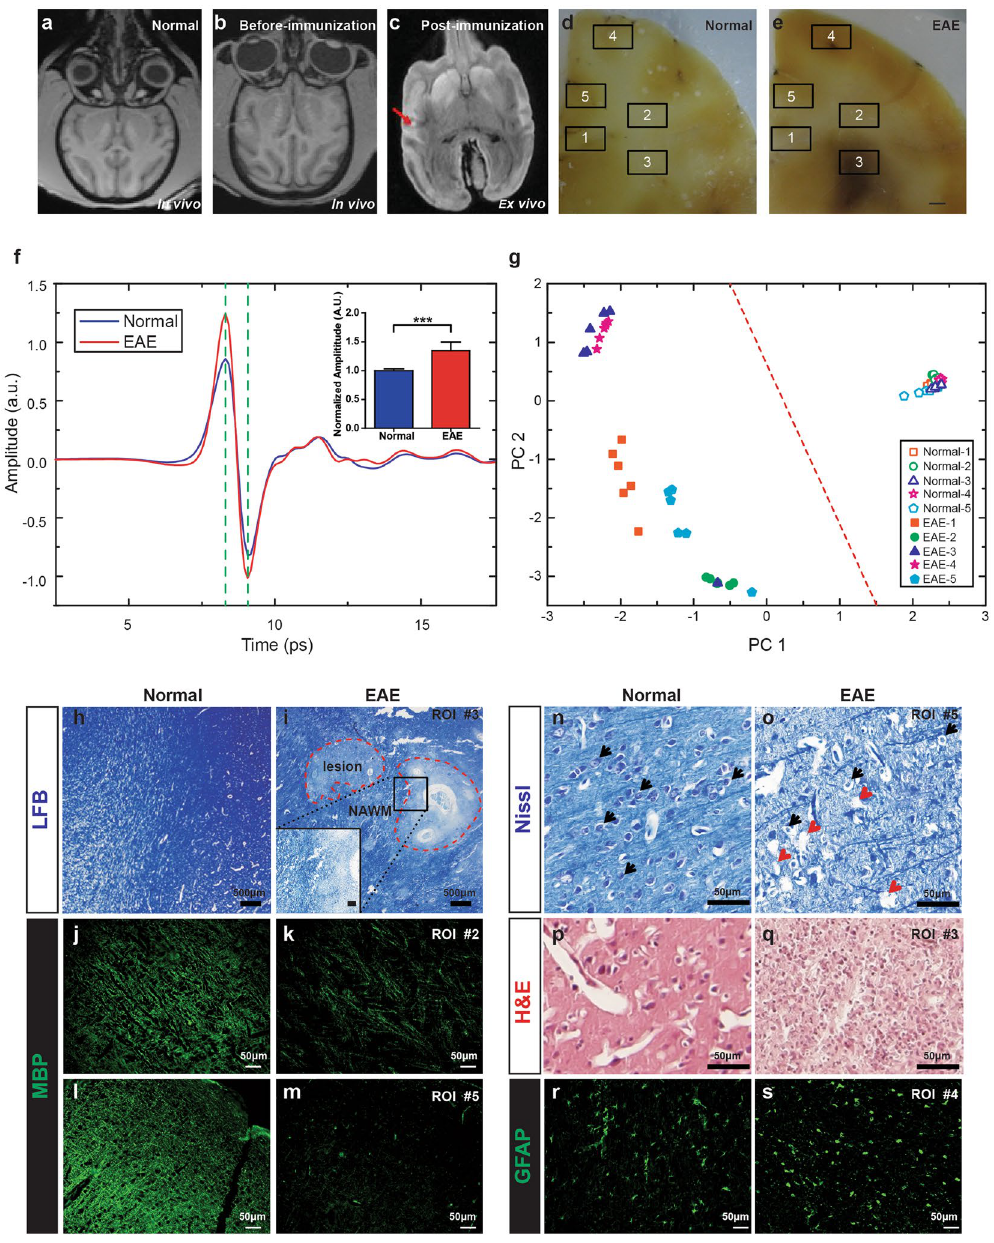
Figure 4. Distinguishing brain from EAE monkey by THz-TDS with PCA. ( a – c ) Examples show MRI of normal monkey, EAE monkey before immunization, and EAE monkey post-immunization. ( d and e ) White- field images of paraffin-embedded brain coronal sections from normal and EAE monkeys. ( f ) THz time- domain waveforms reflected from the regions of interest (ROIs) in normal monkey (blue) and EAE monkey brain samples (red). ( g ) Score plot of the first two principle components for the EAE and normal monkey brain tissues. The solid and hollow figures represent the calculation results for the EAE and the normal brains, respectively. ( h , i ) LFB staining shows completely demyelinated lesions with a sharp border (dashed line) and the surrounding normal appearing white matter (NAWM) in ROI #3 of EAE compare with normal white matter in control monkey. ( j to m ) Immunostaining with MBP antibody shows reduction of MBP + fibers in ROIs #2 and #5 of EAE brain. ( n and o ) Dying neurons (arrows) with condensed nuclei and cavity caused by loss of neuron (arrowheads) were observed in ROI #5 of EAE brain. ( p and q ) Numerous foamy macrophages/microglia were infiltrated in ROI #3 of EAE brain. ( r and s ) Immunostaining of GFAP + astrocytes in ROI #4 of EAE and normal